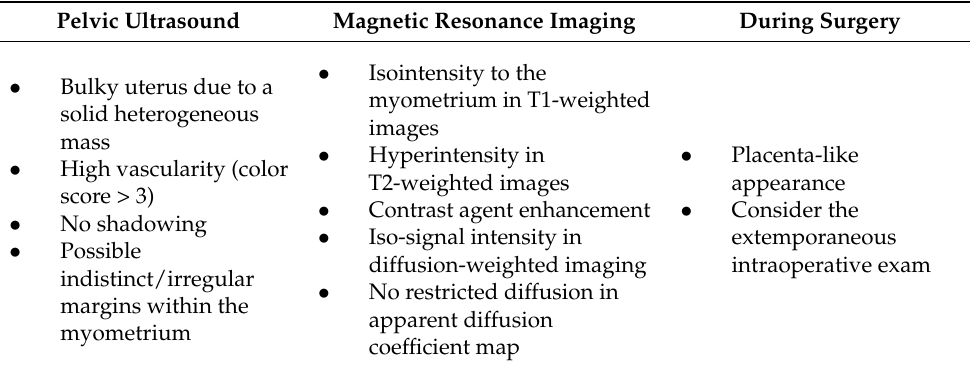
Table 2. Key points when considering a cotyledonoid leiomyoma. Magnetic Resonance Imaging During